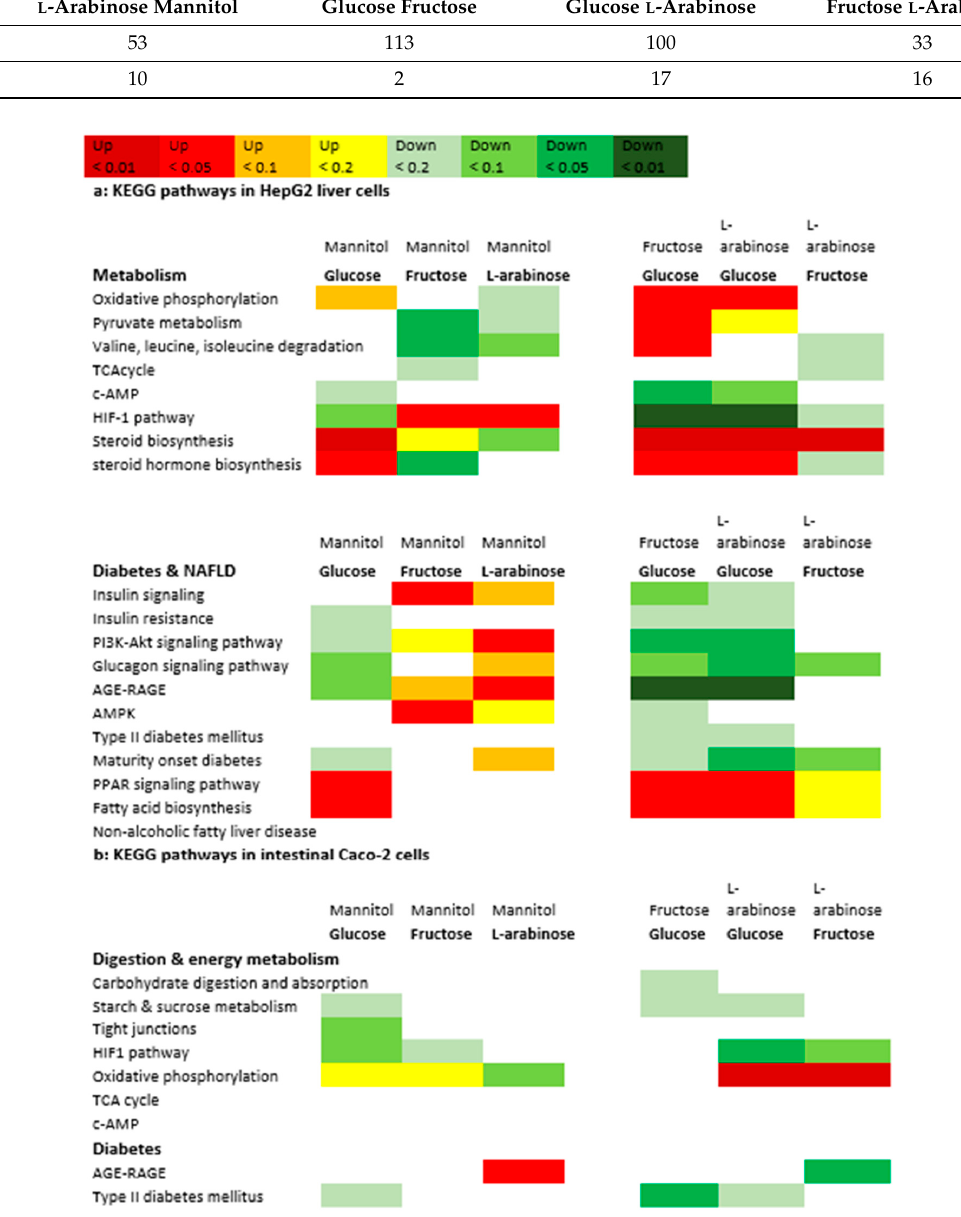
Figure 5. Overview of effects of glucose, fructose and L -arabinose on expression of relevant KEGG pathways in HepG2 ( a ) and Caco-2 cells ( b ).